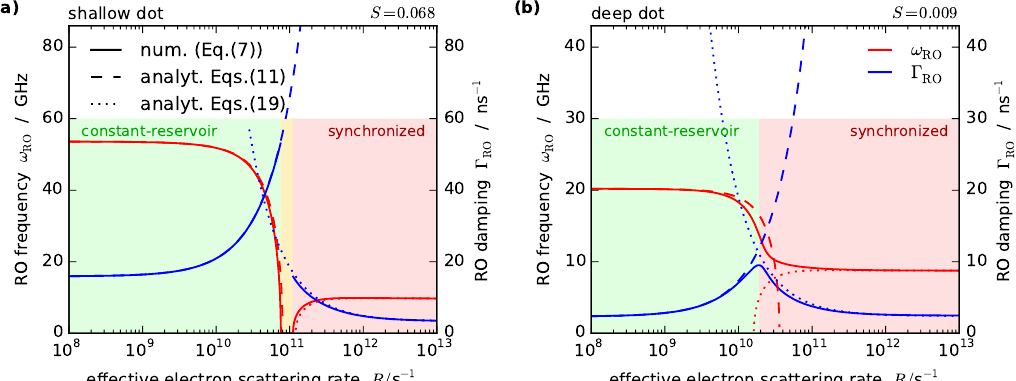
Figure 3. Comparison between the exact eigenvalue solutions of Equation (7) (solid lines) and the analytic approximations of Equation (11) (dashed), and Equation (19) (dotted) for the (a) shallow and (b) deep QD laser in dependence of the effective electron scattering rate R (keeping S constant), cf. Figure